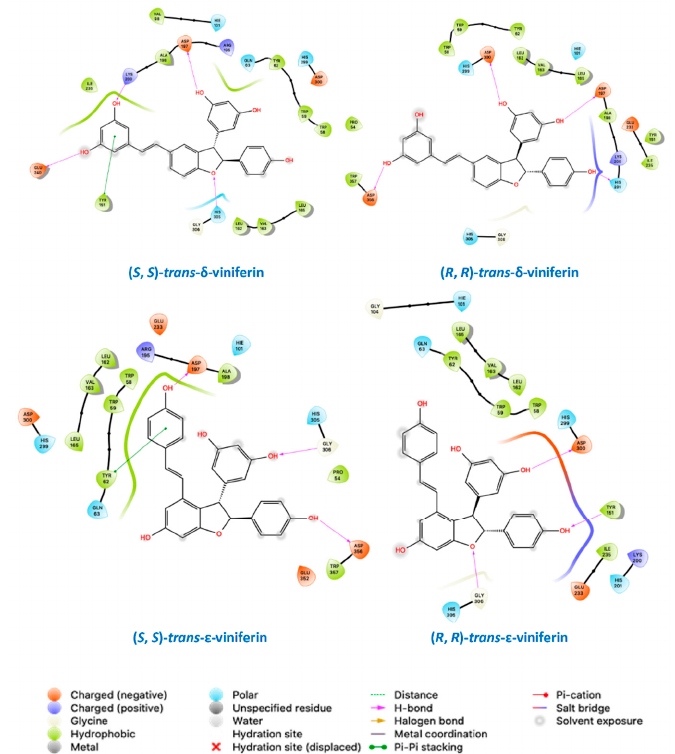
Figure 9. Ligand interaction diagram for the molecular docking top-scoring complexes between the pig pancreatic α -amylase and various enantiomeric forms of the trans -viniferin isomers in the protein active site. Interactions are recapitulated in the figure legend.